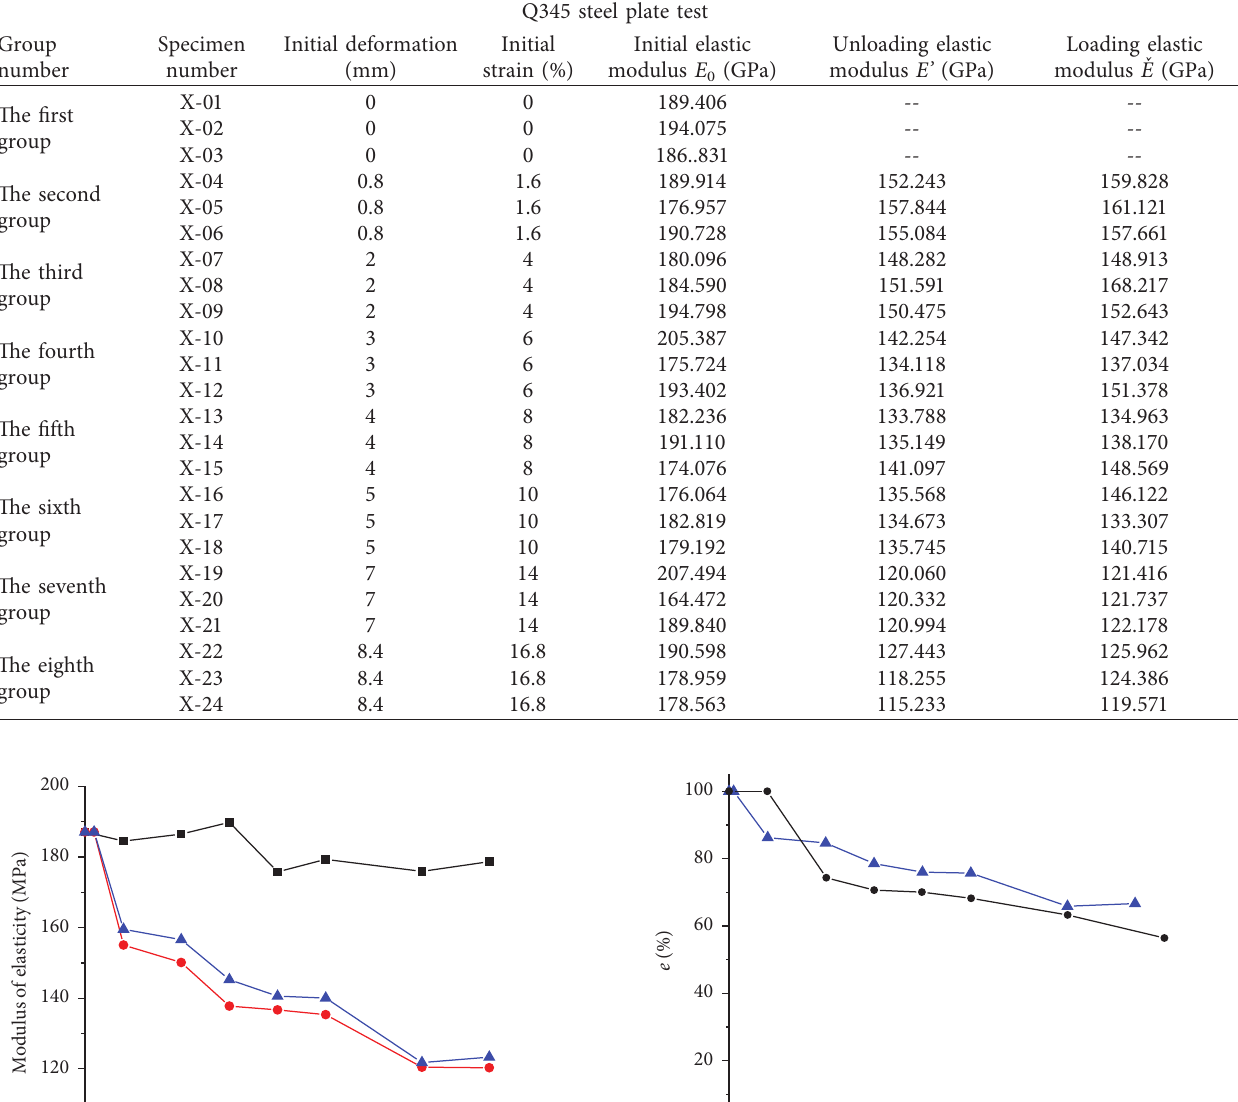
Table 1: Data of tensile test.